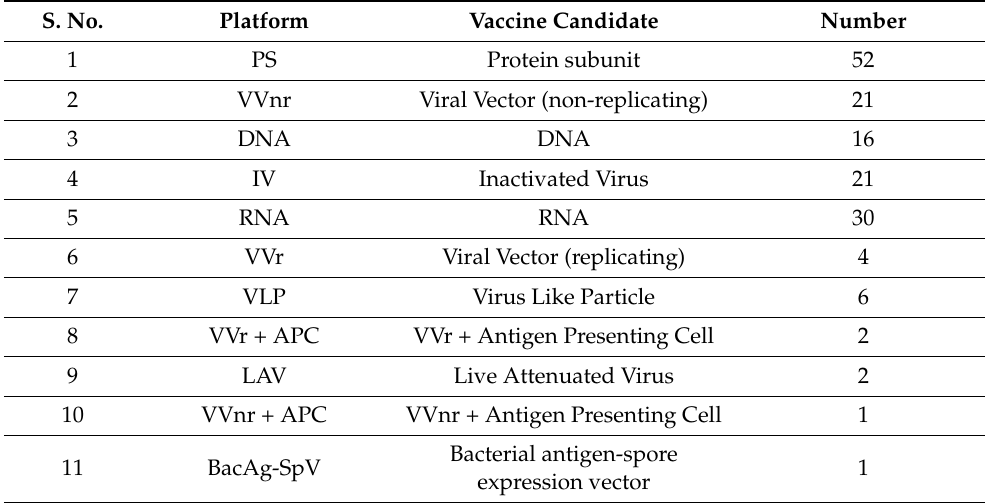
Table 5. Tabular representation of vaccines in clinical